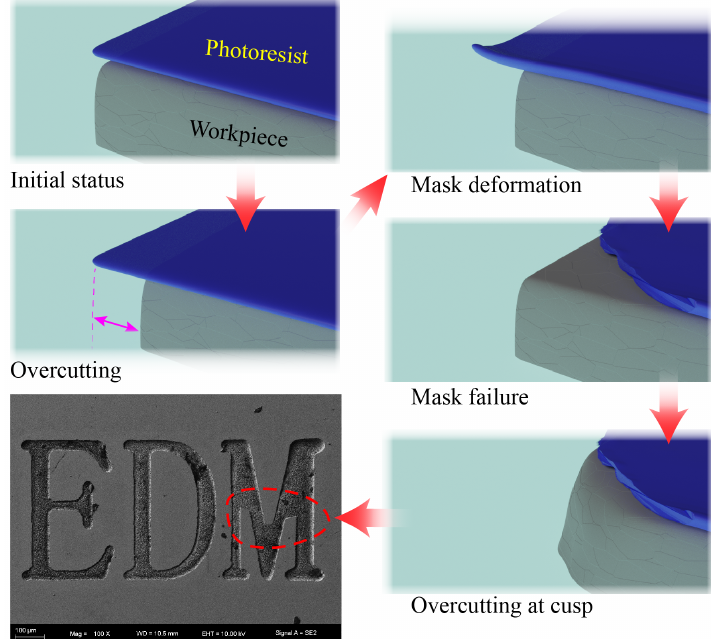
Figure 10. Illustration of mask failure in MEJM and corresponding effect on fabricated shape.